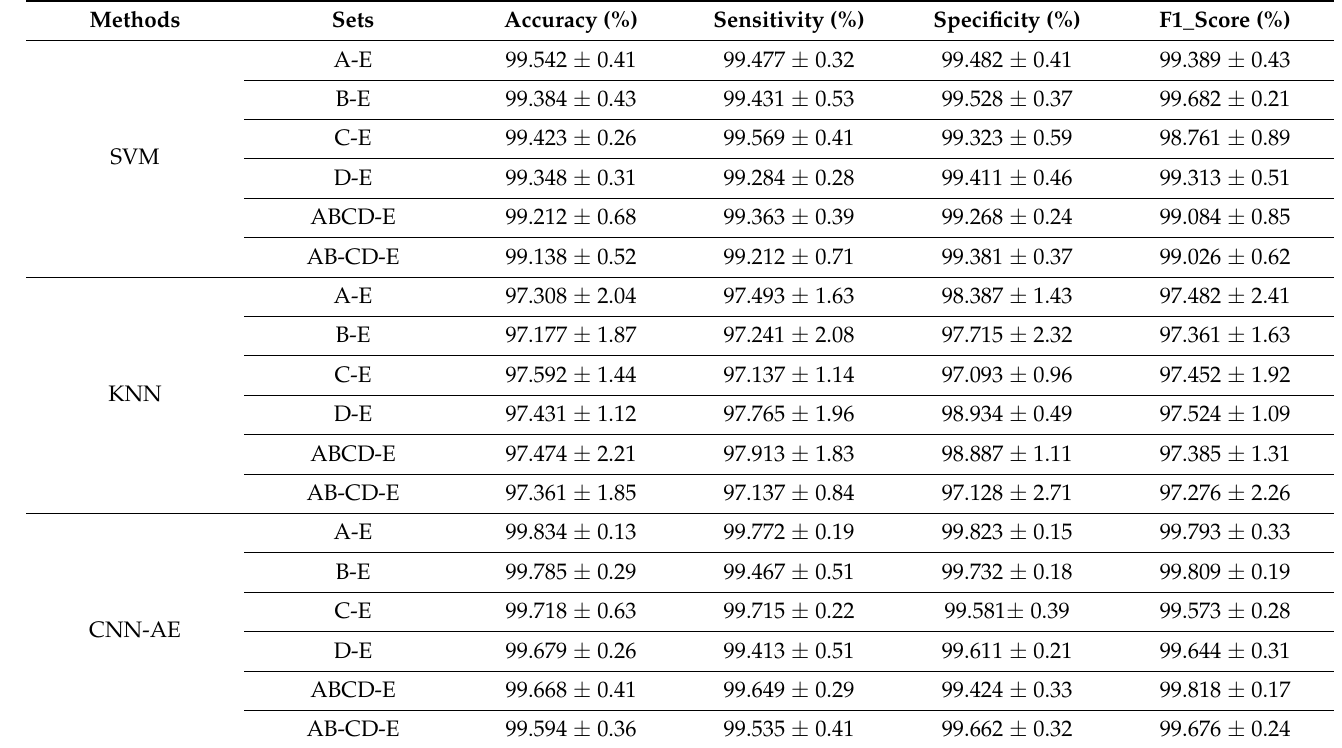
Table 8. Results for the Bonn dataset using different classifier methods alongside mRMR technique.